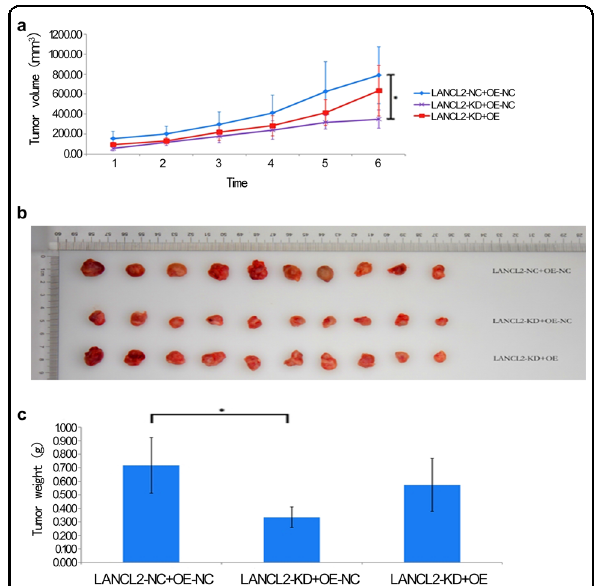
Fig. 6 LANCL2 knockdown reduces PC9 xenograft tumor growth in vivo, while LANCL2 overexpression rescues effects of LANCL2 knockdown. a PC9 xenograft tumor volumes measured over a 6- week period ( n = 10 mice per group). b Images of the extracted PC9 xenograft tumors after 6 weeks. c Quanti fi cation of the fi nal PC9 xenograft tumor weights. * p < 0.05; ** p < 0.01; and *** p < 0.001 vs. LANCL2-NC + OE-NC. Data presented as means ±